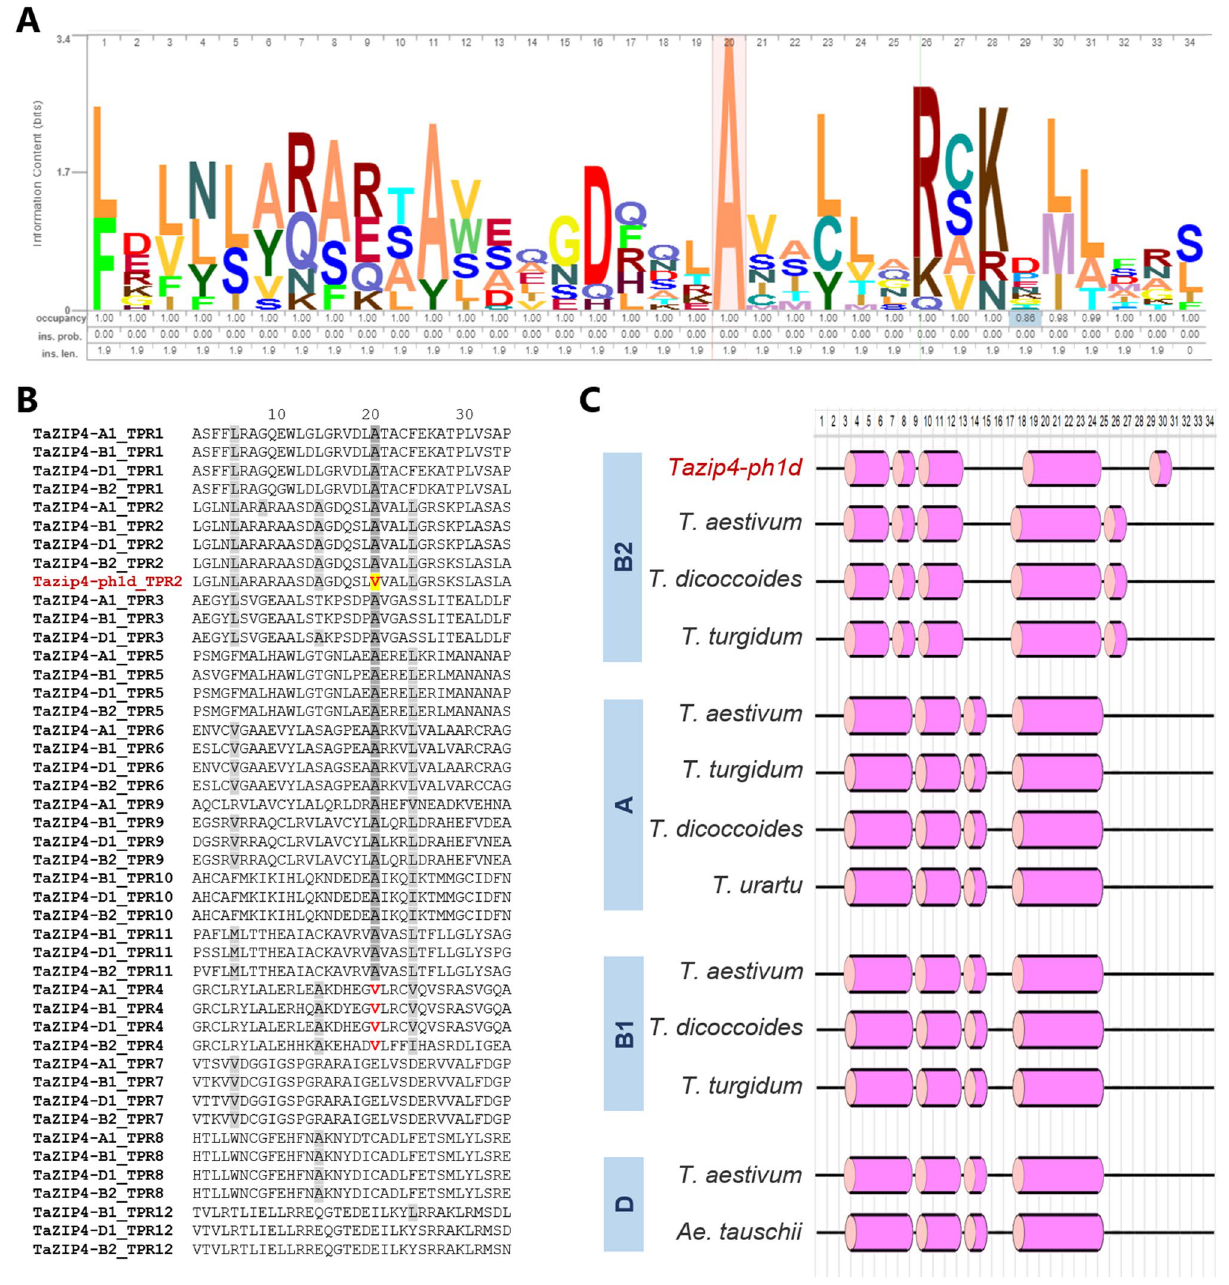
Figure 2. ZIP4 protein sequence analyses. ( A ) Graphic representation of the conserved residues of the TaZIP4-B2 TPR2 domain and the corresponding sequences from a wide range of organisms including plants, animals and yeast. ( B ) Peptide sequence comparison of the TPR domains in the four TaZIP4 proteins. ( C ) Predicted secondary structure of the TPR2 domain in the ZIP4 protein of the Tazip4-ph1d mutant, compared with those of hexaploid and tetraploid wheat, and their progenitors. The secondary structure was predicted using the PSSM random forest-based model in the PEP2D server. Helix is represented by the pink cylindrical shape and coil is represented as a black